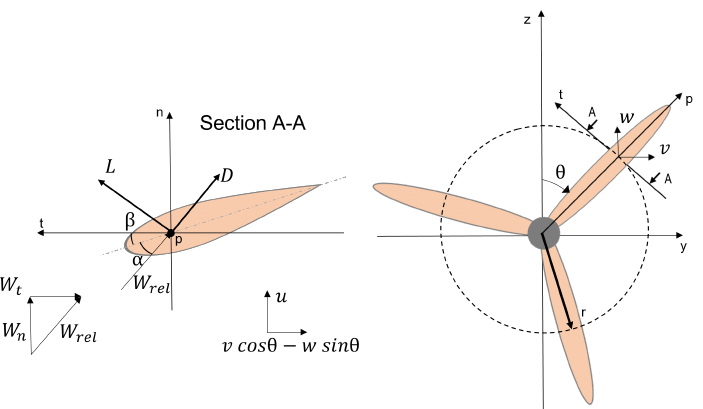
Figure 1. Qualitative representation of the forces acting on a blade element, located at a generic radius r , and shown from section